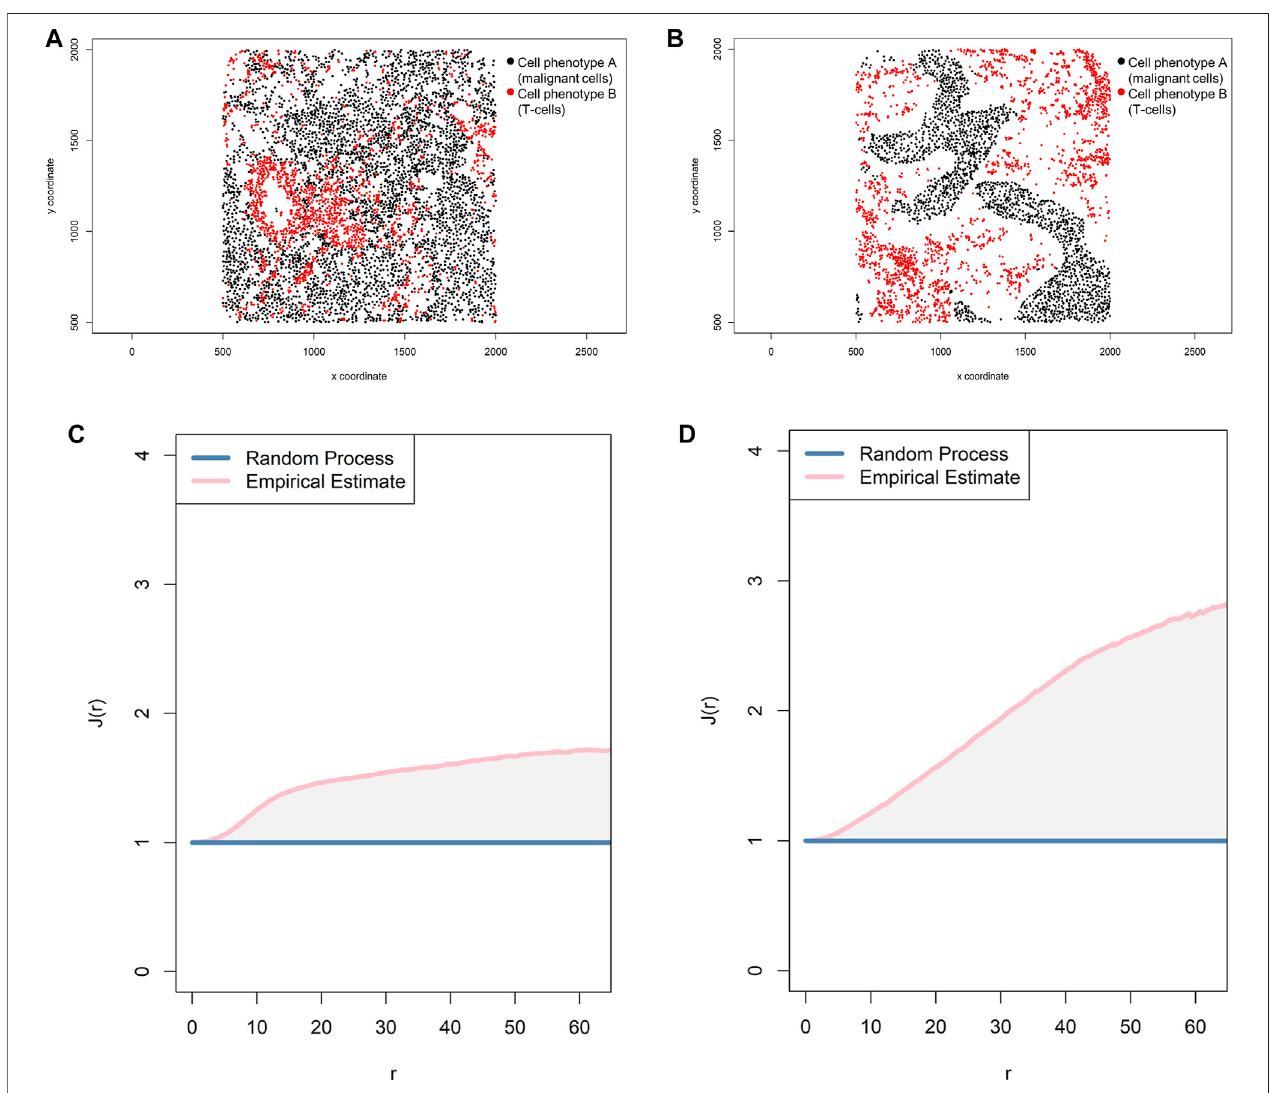
FIGURE 11 | Representative graphs showing the J-function [J( r )] for two different cell populations, illustrating the cellular distribution between the two groups of cells using a representative point pattern in multiplex immuno fl uorescence images of lung adenocarcinoma. (A) Random point pattern distribution of cell phenotype A and B. (C) Graphic representation of the J( r ) curve showing its lineup with the theoretical estimate (Poisson line), characterizing a random or mixed pattern of one cell population in relation to another cell population. (B) Unmixed point pattern distribution of cell phenotype A and B. (D) Graphic representation of the J( r ) curve showinghighlyincreaseddistanceabovethetheoreticalestimate(Poissonline),characterizingaclusteringorunmixedpatternofonecellpopulationinrelationtoanother cell population. The graphics were generated using R studio software version